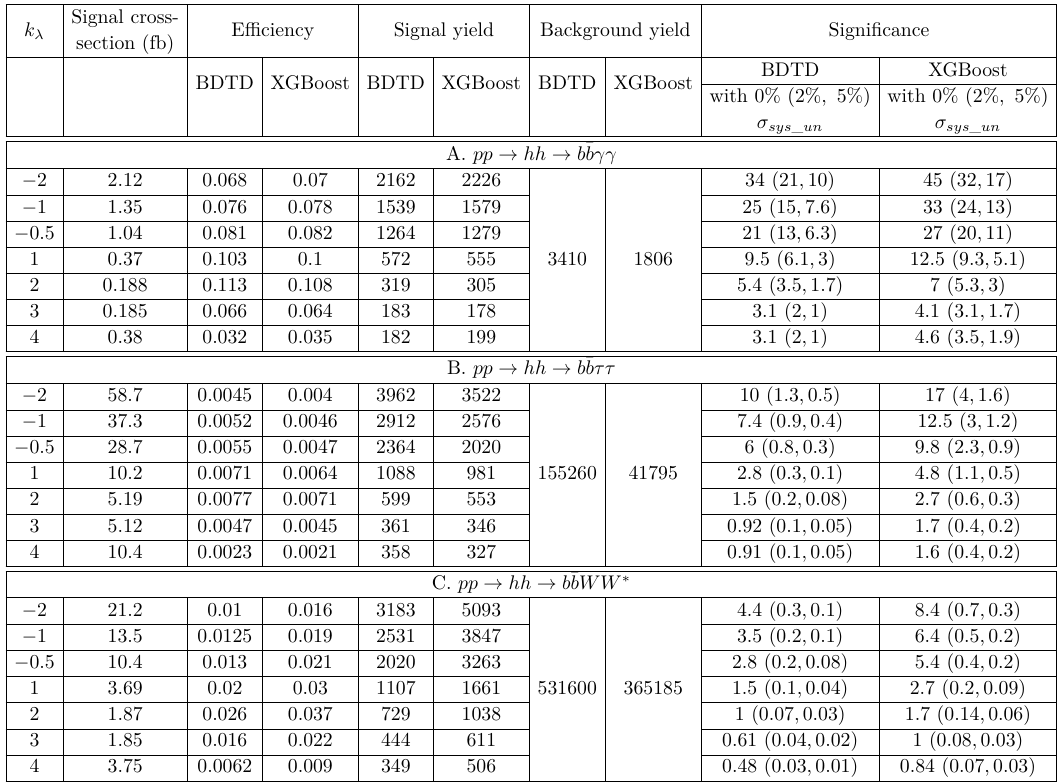
Table 10 . The cross-sections, signal efficiencies, signal yields, background yields, and the signal significances at the HE-LHC, obtained from the BDTD and the XGBoost analysis are listed along with the respective values of k λ for σ sys _ un = 0% , 2% and 5%